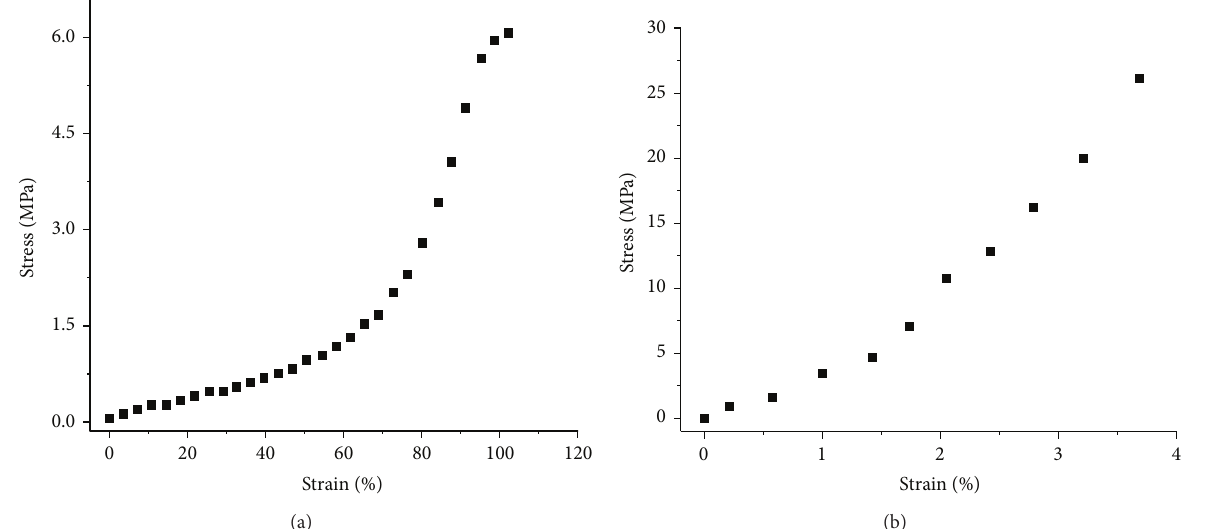
Figure 4: Typical tensile behavior of neat (0% IL) RTV 655 at (a) room temperature and (b) 77 K. The stress strain curve of RTV 655 at room temperature follows a classic elastomeric behavior. The increased strength of the polymer at 77 K reflects reduced mobility of the polymer chains and significant stiffening without geometrical changes such as